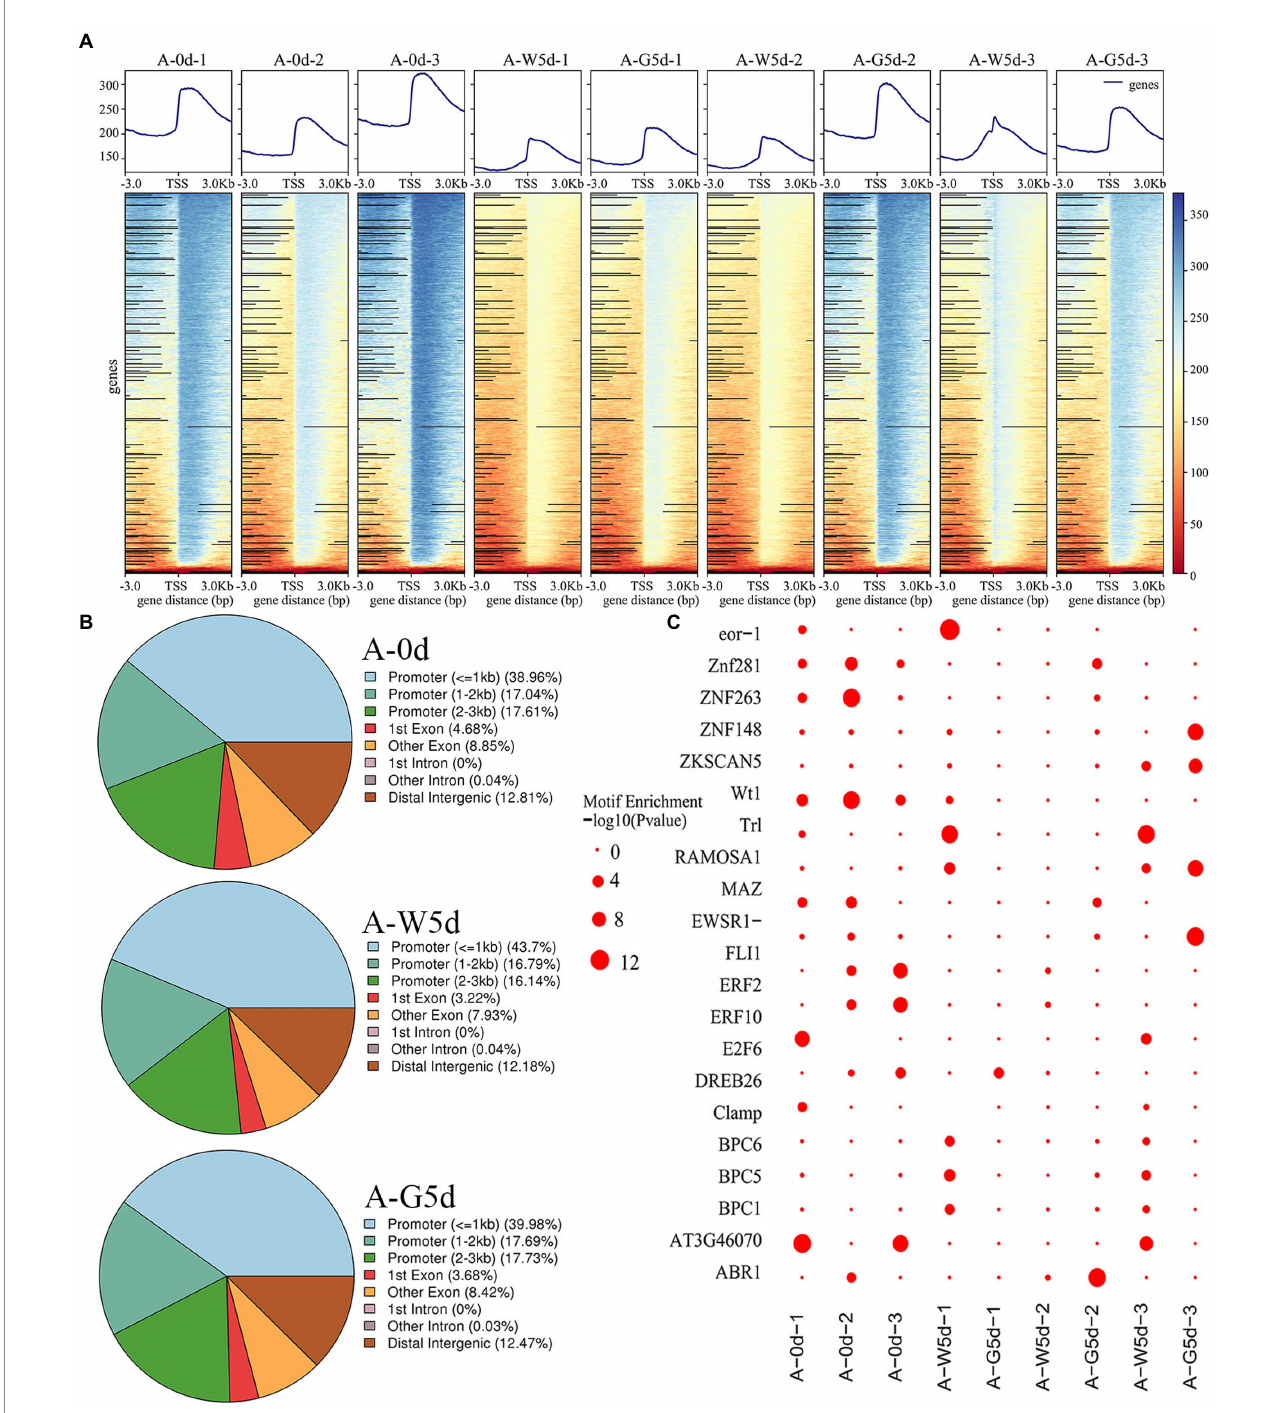
FIGURE 2 Changes and distribution of chromatin accessibility regions. (A) Distribution density map of ATAC data near the TSS. ( B ) Distribution of open chromatin regions accessibility within different genomic regions in A-0d, A-W5d, and A-G5d, respectively. (C) Enrichment diagram of transcription factor motifs. Samples were used for ATAC sequencing, namely A-0d, A-W5d, and A-G5d, and each sample was sequenced three